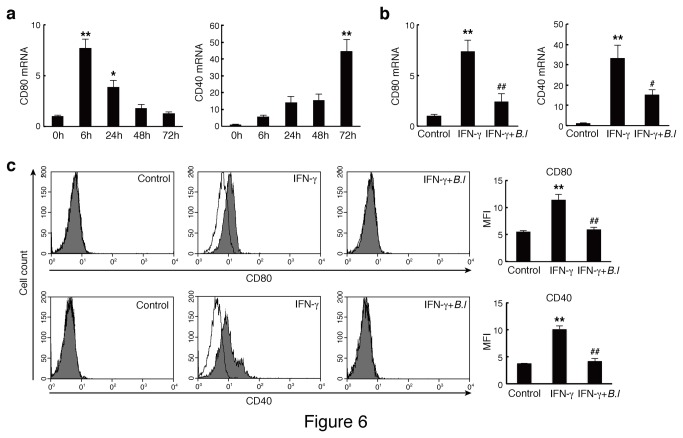

B. longum JCM 1222T (B.l) suppresses the expression of costimulatory molecules in Colon-26 cells.(a) mRNA expression of CD80 and CD40 was analyzed by quantitative real-time PCR in Colon-26 cells after stimulation with IFN-γ. Levels of mRNA were normalized to β-actin mRNA, and expressed relative to before stimulation (0 h). Results are expressed as means ± standard error (n = 4). *
p<0.05 and **
p<0.01 versus before stimulation (0 h). (b) Colon-26 cells were pre-incubated with B. longum JCM 1222T, and then treated with penicillin and streptomycin and incubated with IFN-γ. Messenger RNA expression of CD80 and CD40 was analyzed after stimulation with IFN-γ for 6 and 72 h, respectively. The data are representative of three experiments. (c) Colon-26 cells were incubated with B. longum JCM 1222T and IFN-γ. Cell surface protein expression of CD80 and CD40 was analyzed by flow cytometry after stimulation with IFN-γ. Debris was gated out by forward and side scatter. Histograms show a representative experiment (specific antibody stains are shown in filled histograms, and isotype control antibody stains are shown in open histograms) and bar figures are representative of two experiments. **
p<0.01 versus non-treated cells (Control); #
p<0.05 and ##
p<0.01 versus IFN-γ-stimulated cells.